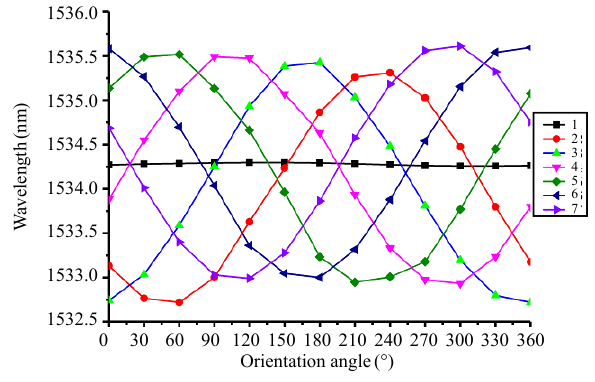
Fig. 9 Bragg wavelength shifts at different bending orientations.